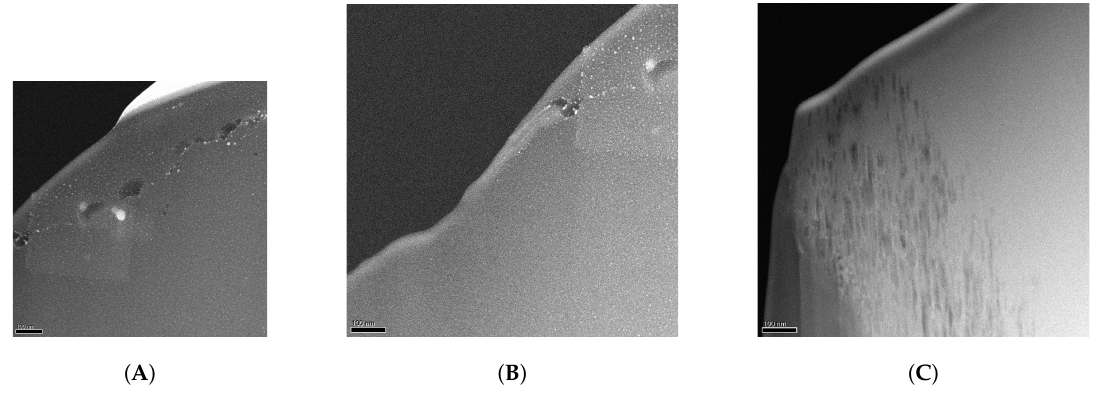
Figure 4. TEM dark field image (cross-section) with two areas of interest: region of interest A (ROIA) and region of interest B (ROIB) at the edge of the carbon fiber in the low-loss region of untreated carbon fiber ( A , B ) and the edge of treated carbon fiber ( C ). (A) Region A; (B) Region B; (C) treated CF.